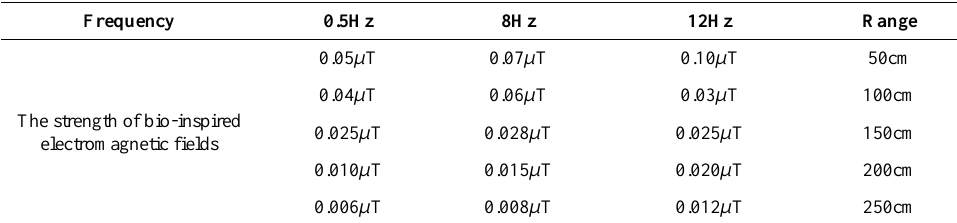
Table 2. The strength of the